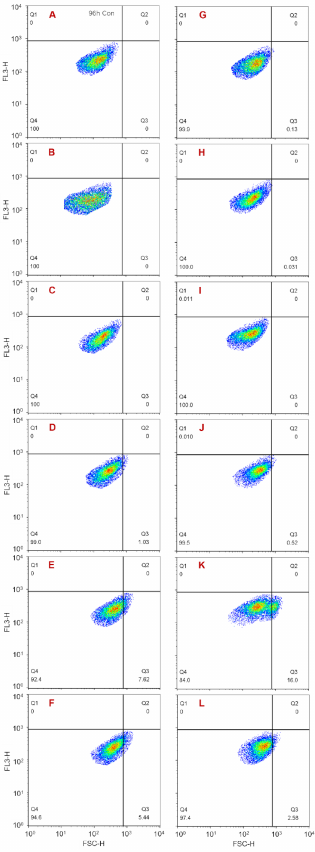
Figure 3. Changes in the cell size of residual A. anophagefferens (CCMP 1984) within 96 h after treatment with NC or MC. ( A , G ) Normal cells measured at 3 h and 96 h, respectively (group 1); ( B – F ) residual cells treated with NC measured at 3 h, 24 h, 48 h, 72 h, and 96 h, respectively (group 2); ( H – L ) residual cells treated with MC measured at 3 h, 24 h, 48 h, 72 h, and 96 h, respectively (group